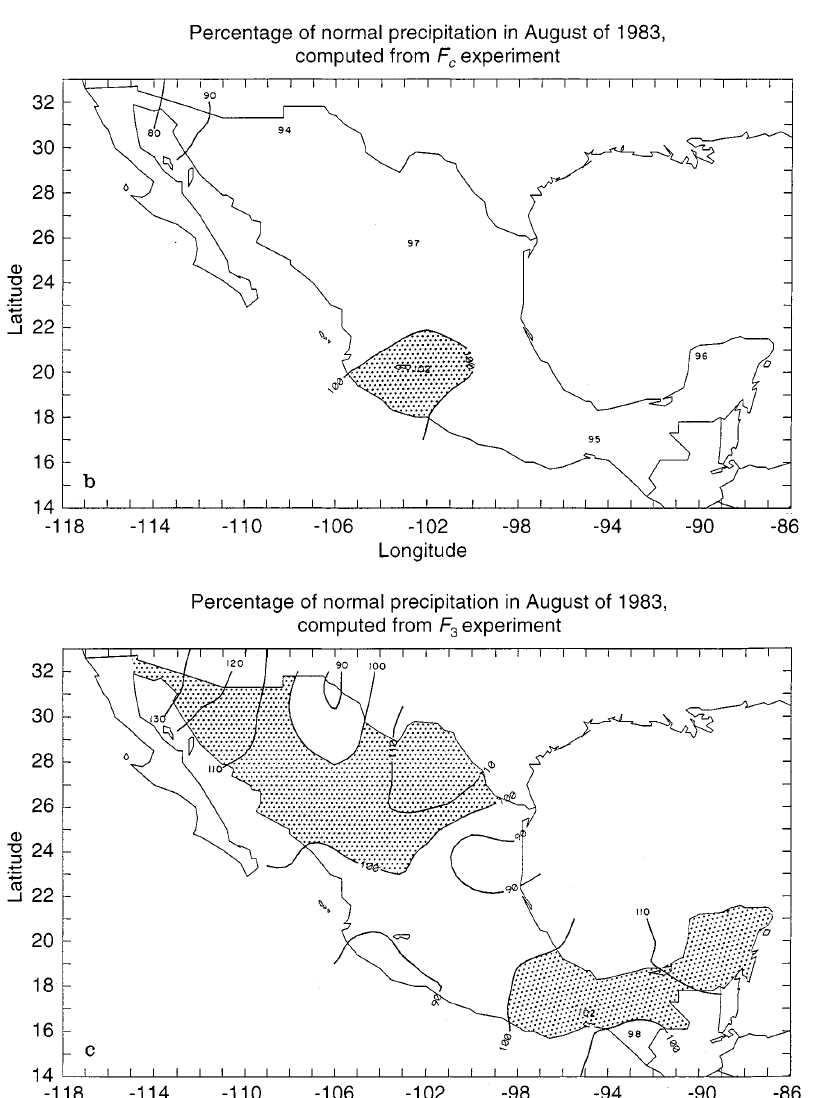
Fig. 6a–c. Percentage of normal precipitation in August 1983 in Mexico. The areas where the percentage is above 100% are shaded. a Observed precipitation, b computed precipita- tion in F c experiment, and c computed precip- itation in F